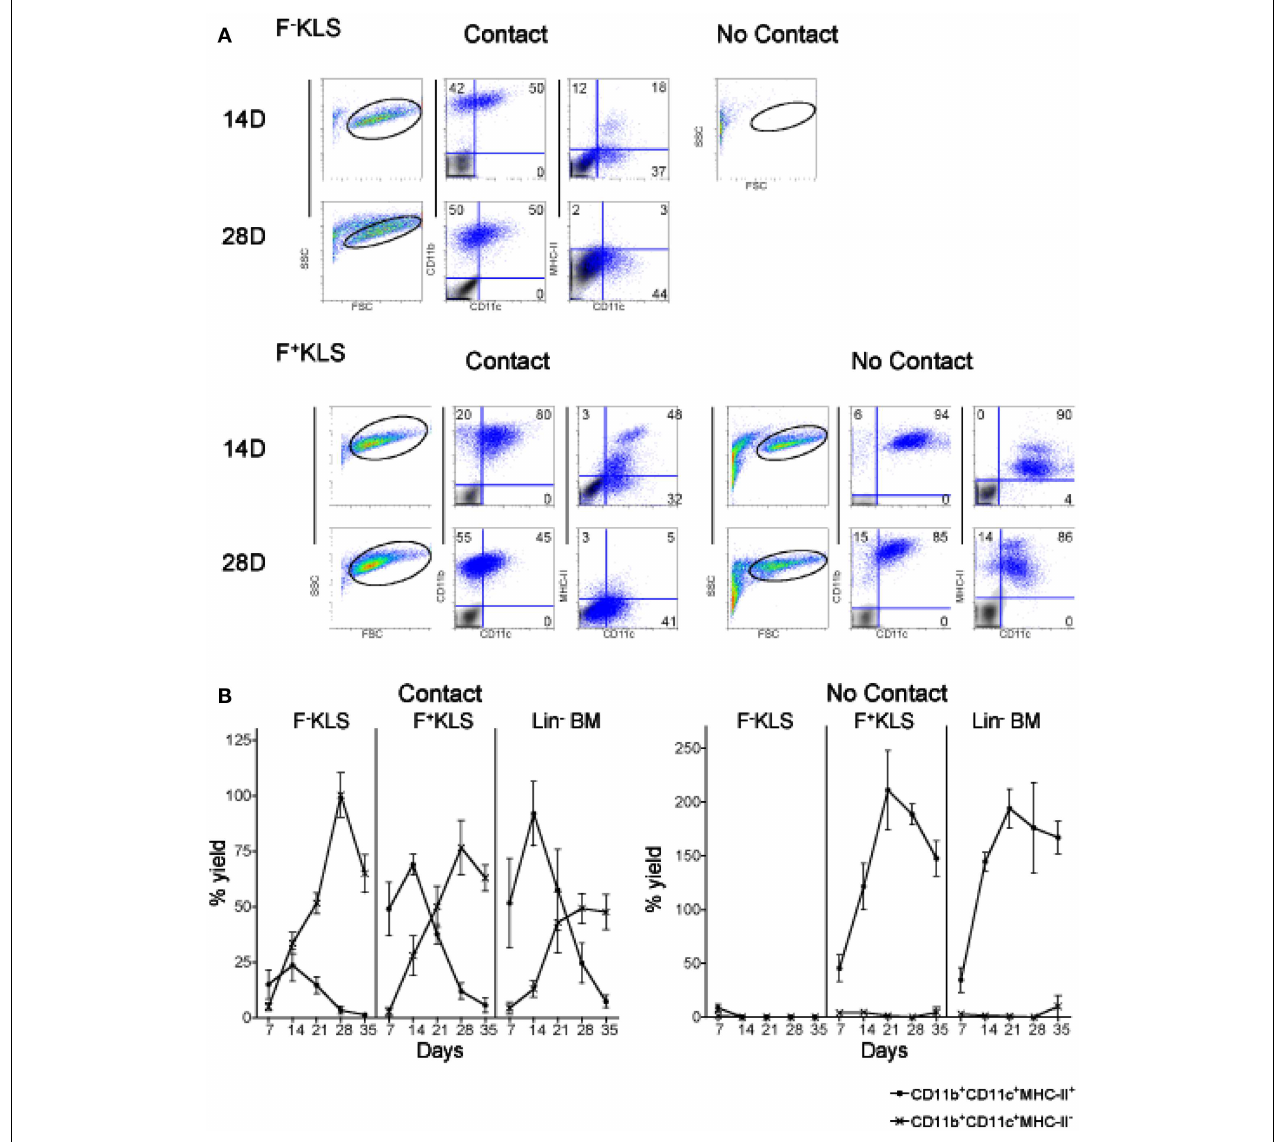
control staining, shown as a gray density plot overlay, was used to set gates indicating background binding. Numbers shown in quadrants represent % positive cells. (B) The percent yield of live CD11c + CD11b + MHC-II − (L-DC) and CD11c + CD11b + MHC-II + (cDC-like) cells in co-cultures was estimated relative to input cell number.Three replicate experiments were assessed. Data represent mean ± SE ( n = 3). By day 28, production of L-DC was significantly greater than cDC-like cells ( p ≤ 0.05) for all productive